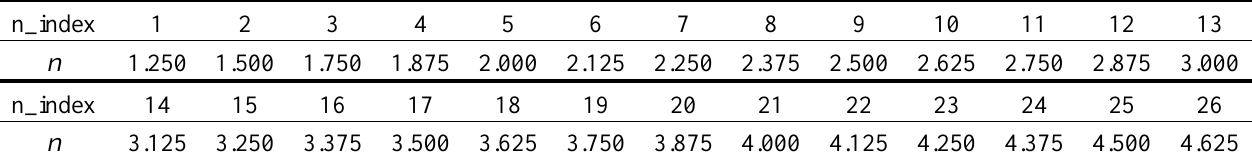
Table 4. n parameter lookup table.